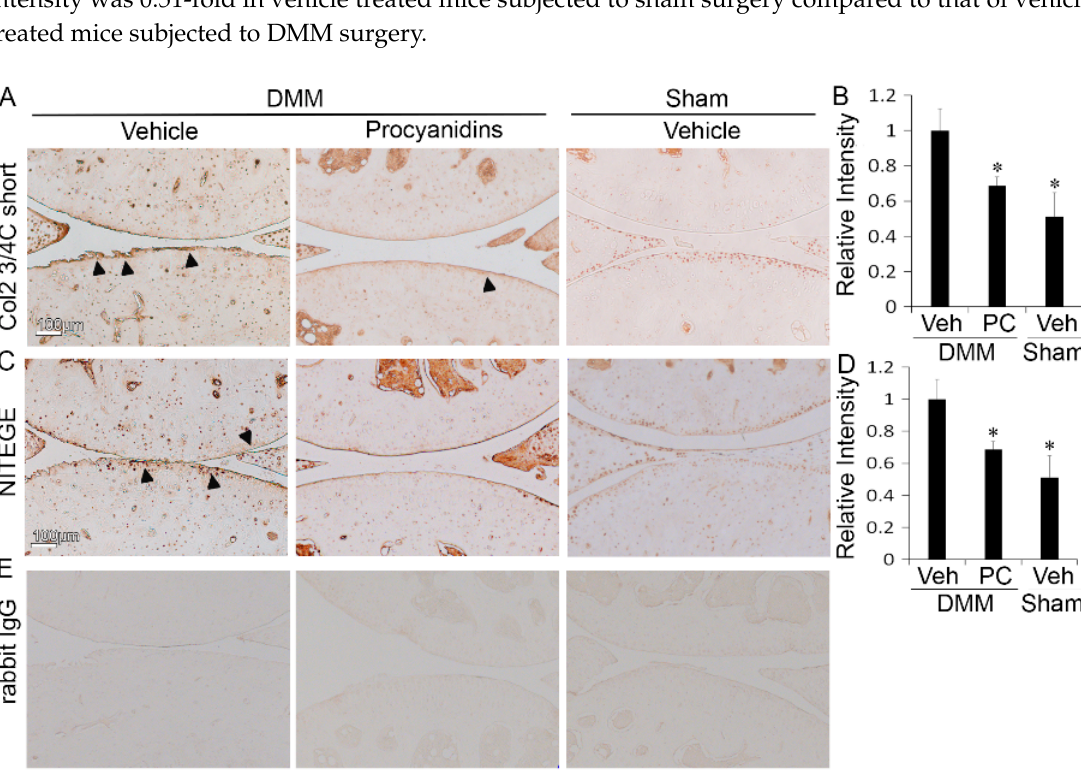
Figure 2. Oral administration of procyanidins reduced matrix degradation of articular cartilage in mice subjected to DMM surgery. Immunohistochemical staining of type II collagen cleavage epitope (Col2 3/4C short) ( A ) and cleaved aggrecan (NITEGE) ( C ); The relative staining intensities of Col2 3/4C short ( B ); and NITEGE ( D ) of the articular cartilage matrix in mice subjected to DMM and treated with procyanidins (PC) were significantly reduced compared to that in mice subjected to DMM and treated with vehicle (Veh); ( E ) representative immunostaining of tissue sections with isotype control (rabbit immunoglobulin G, IgG). Scale bar = 100 µm. * p < 0.05 by one-way ANOVA with Tukey post-hoc test; n = 4/group. Arrows denote representative regions with positive immunostaining of type II collagen cleavage epitope (Col2 3/4C short) ( A ) and cleaved aggrecan (NITEGE) ( C ).